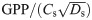
Surface conductance (Gsw) plotted against GPP/(CsDs).The slope of the relationship corresponds approximately to the G1,USO parameter (Eq 23). Different colors denote the ratio of bulk intercellular CO2 concentration (Ci; Eq 25) to ‘big-leaf’ surface CO2 concentration (Cs; Eq 13). Shown are data for rainfree periods in the growing season of 2012 (see text for details on data filtering).